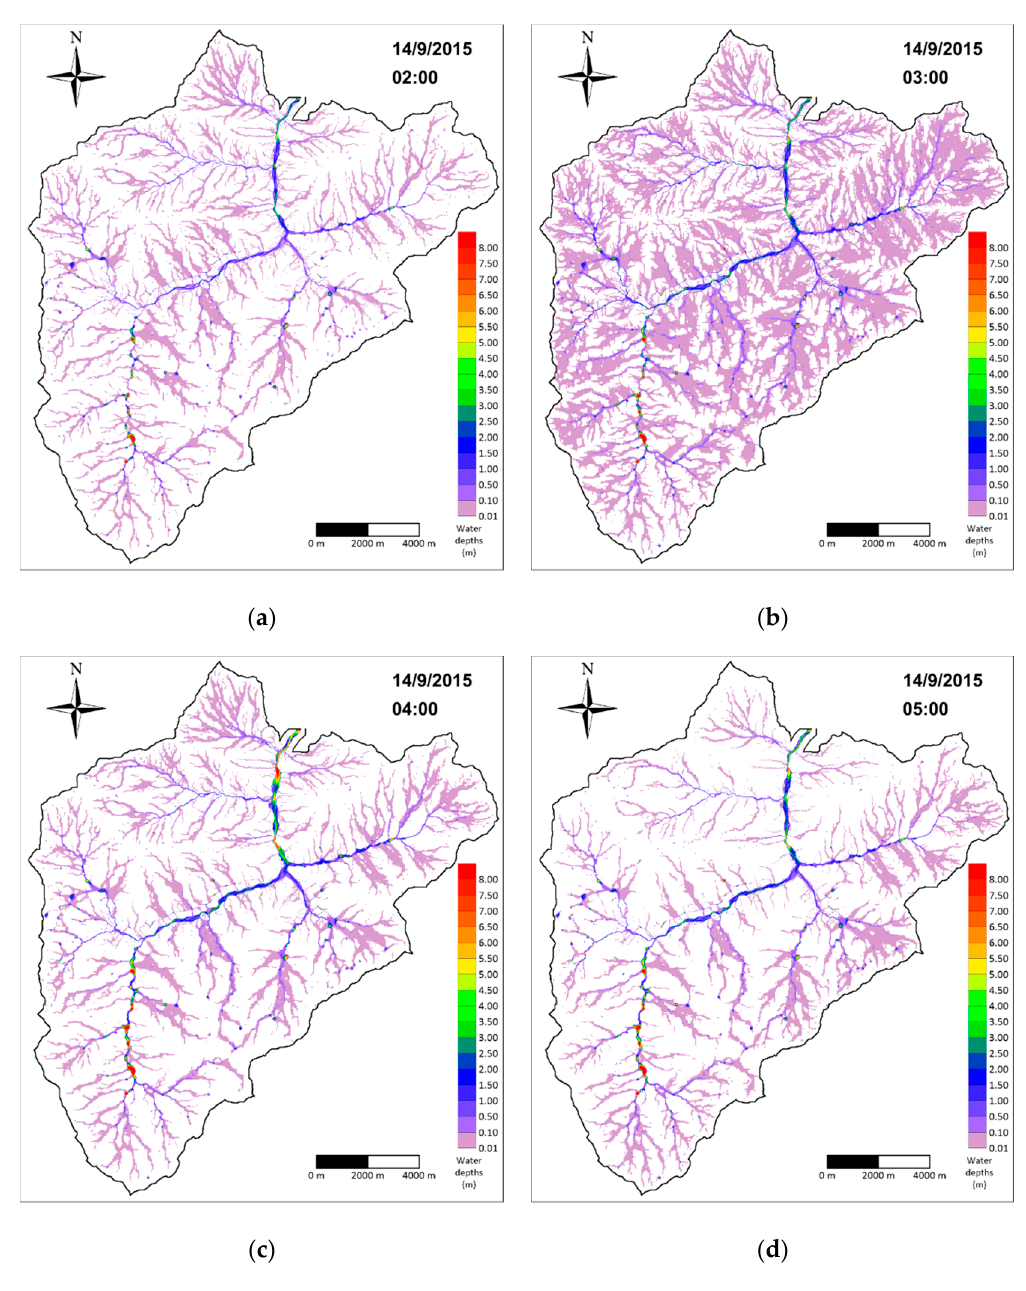
Figure 19. Computed water depths for the whole Nure watershed from 02:00 UTC+1 to 05:00 UTC+1 on 14 September 2015: ( a ) 02:00 UTC+1; ( b ) 03:00 UTC+1; ( c ) 04:00 UTC+1 and ( d ) 05:00 UTC+1.